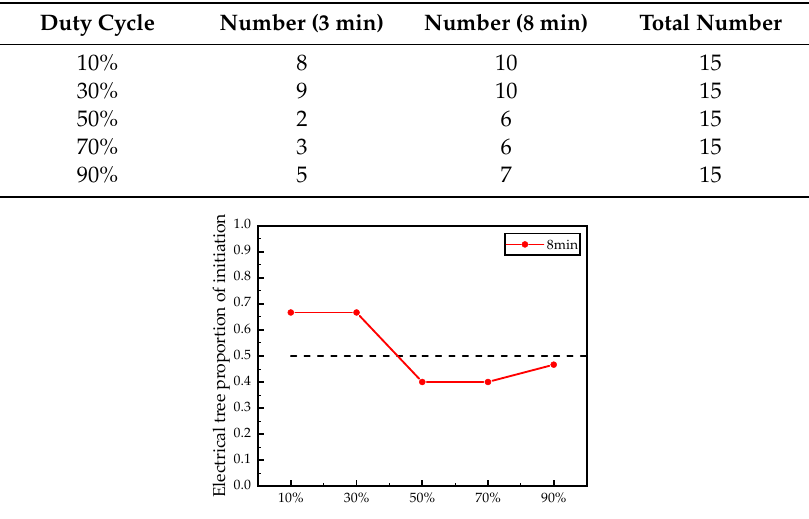
Table 2. Number of tree initiation.